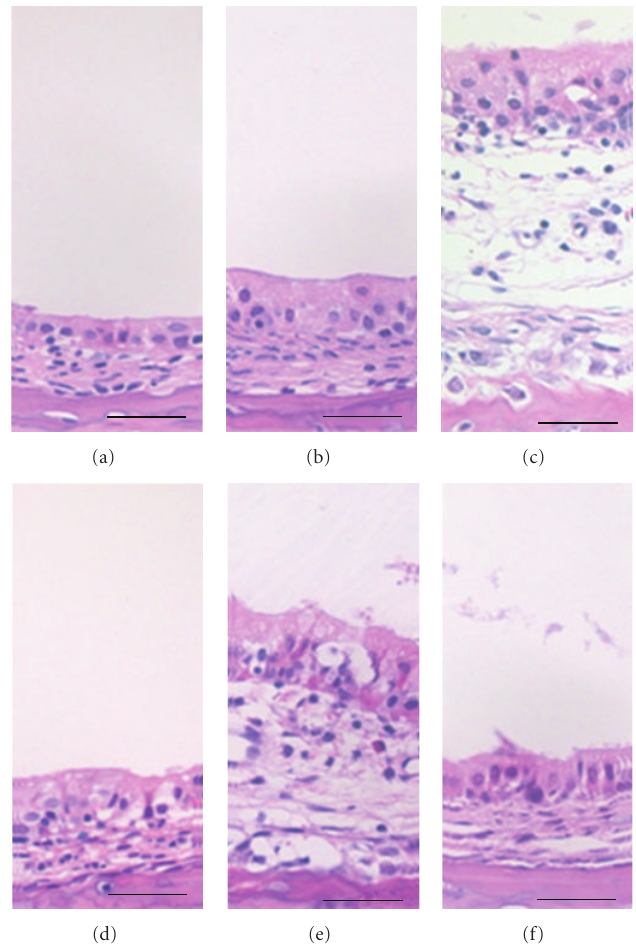
Figure 2: Photomicrographs of sinus mucosa on the 4th day. The mucosa was thin in the normal (a) and saline (b) control groups. In the LPS group (c), the mucosa was markedly thickened. The sTNFRI (d), antibiotic (e), and sTNFRI/antibiotic (f) groups showed significant decreases in mucosal thickening compared with the LPS group (c) (hematoxylin-eosin staining; scale bar = 1 mm).